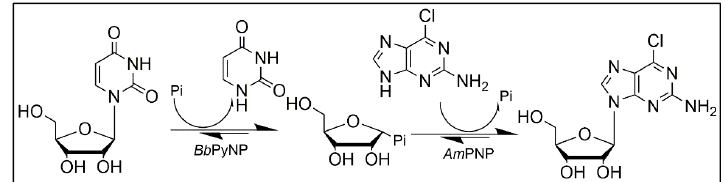
Figure 4. Effect of temperature and pH on biosynthesis of 2-amino-6-chloropurine ribonucleoside Bb PyNP: Am PNP in a ratio of 2:20 μ g/mL. The reaction mixture (1.0 mL) contained 20 mM uridine